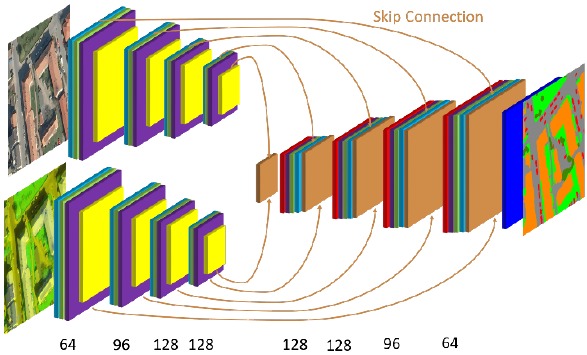
Figure 3. Architecture of FuseEnc . Colour code: cf. Fig.